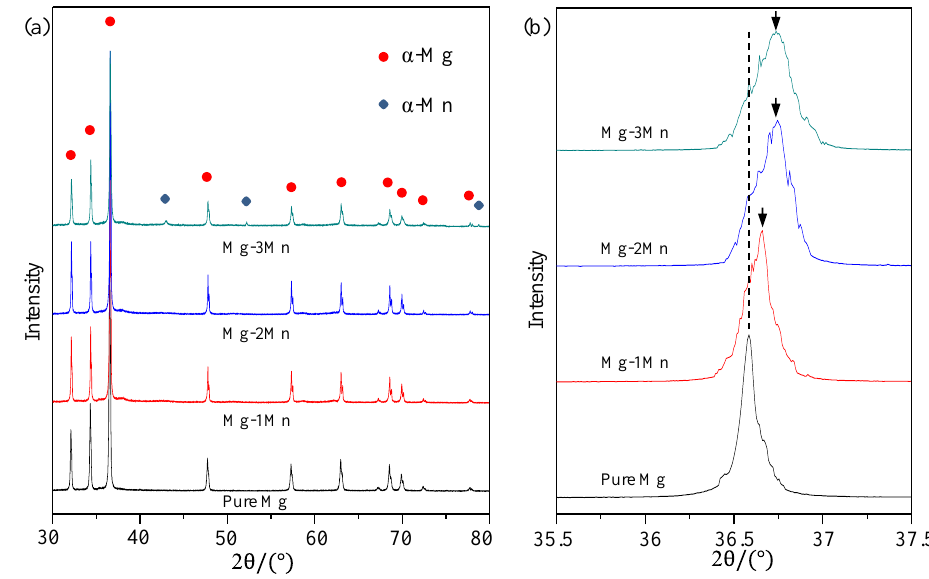
Figure 2. ( a ) X-ray diffractometer (XRD) spectrum of rapid laser-melted Mg-Mn alloy obtained over 30°–80°; ( b ) XRD spectra in the vicinity of the standard diffraction peak of Mg 2θ = 36.53°.